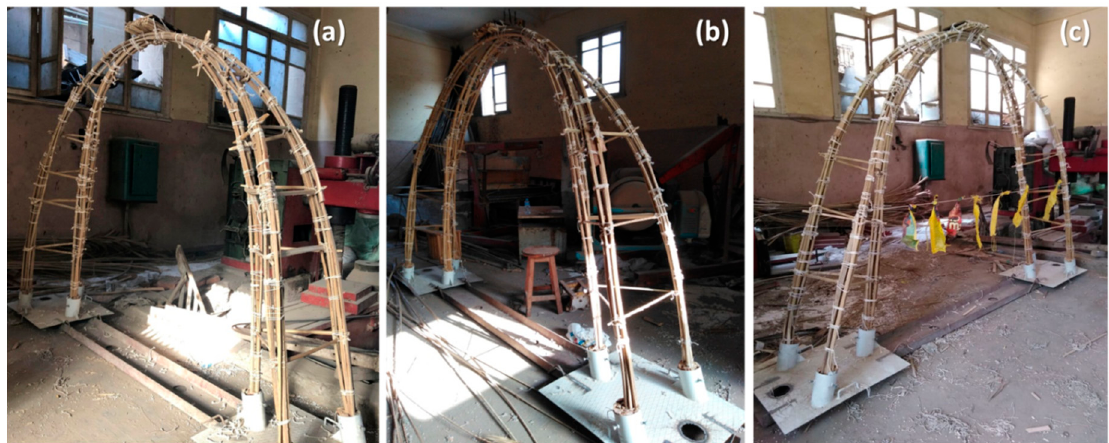
Figure 14. The specimens after completion. ( a ) The first specimen. ( b ) The second specimen. ( c ) The third specimen.